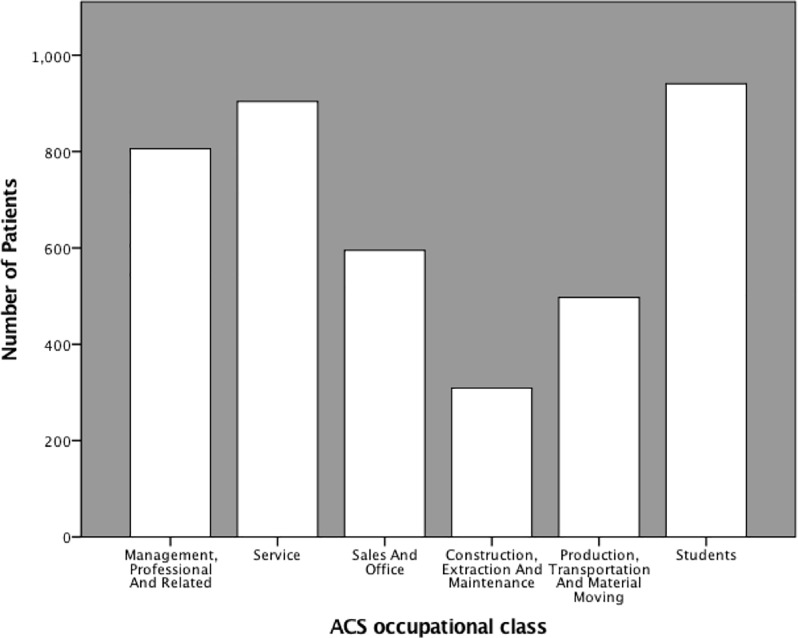
Distribution of occupational class.